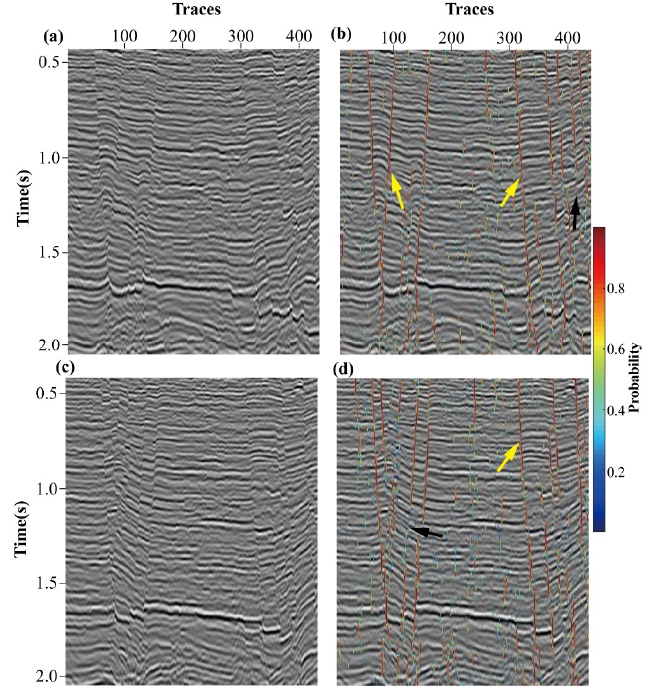
Figure 8. Fault detection test on Data1 sections: ( a ) and ( c ) two Inline sections from Data1; and ( b ) and ( d ) the corresponding prediction results.